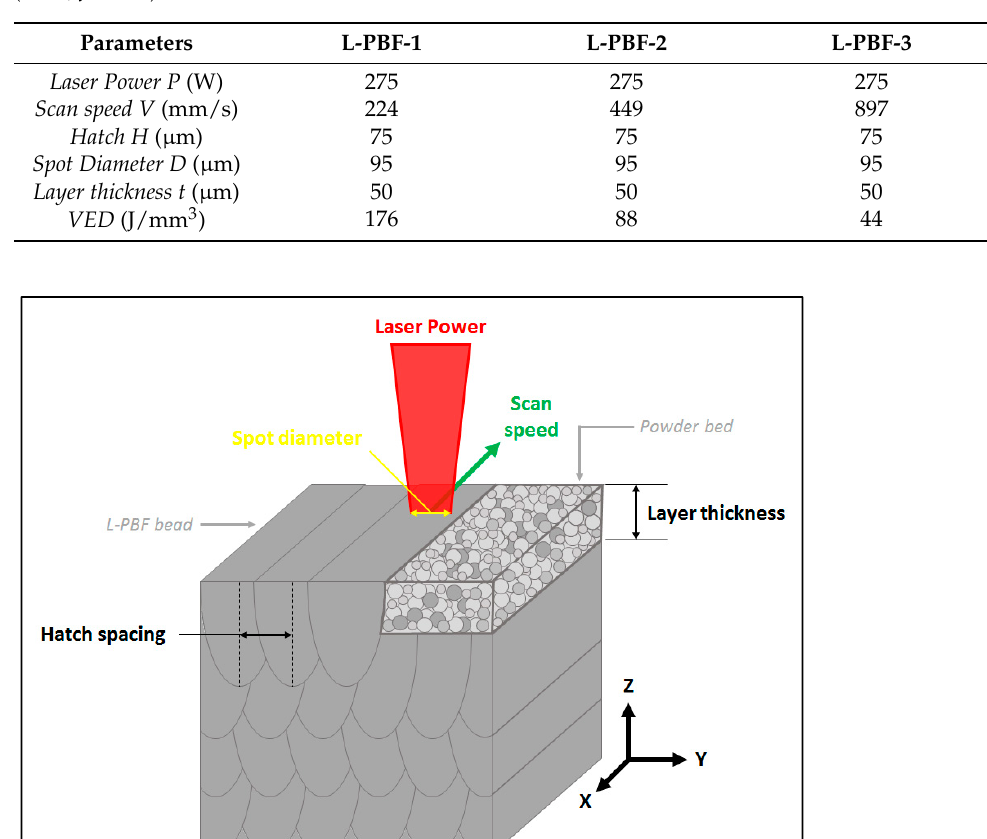
Table 1. Laser-powder bed fusion (L-PBF) process parameters, including the volume energy density ( VED ; J/mm 3 ).